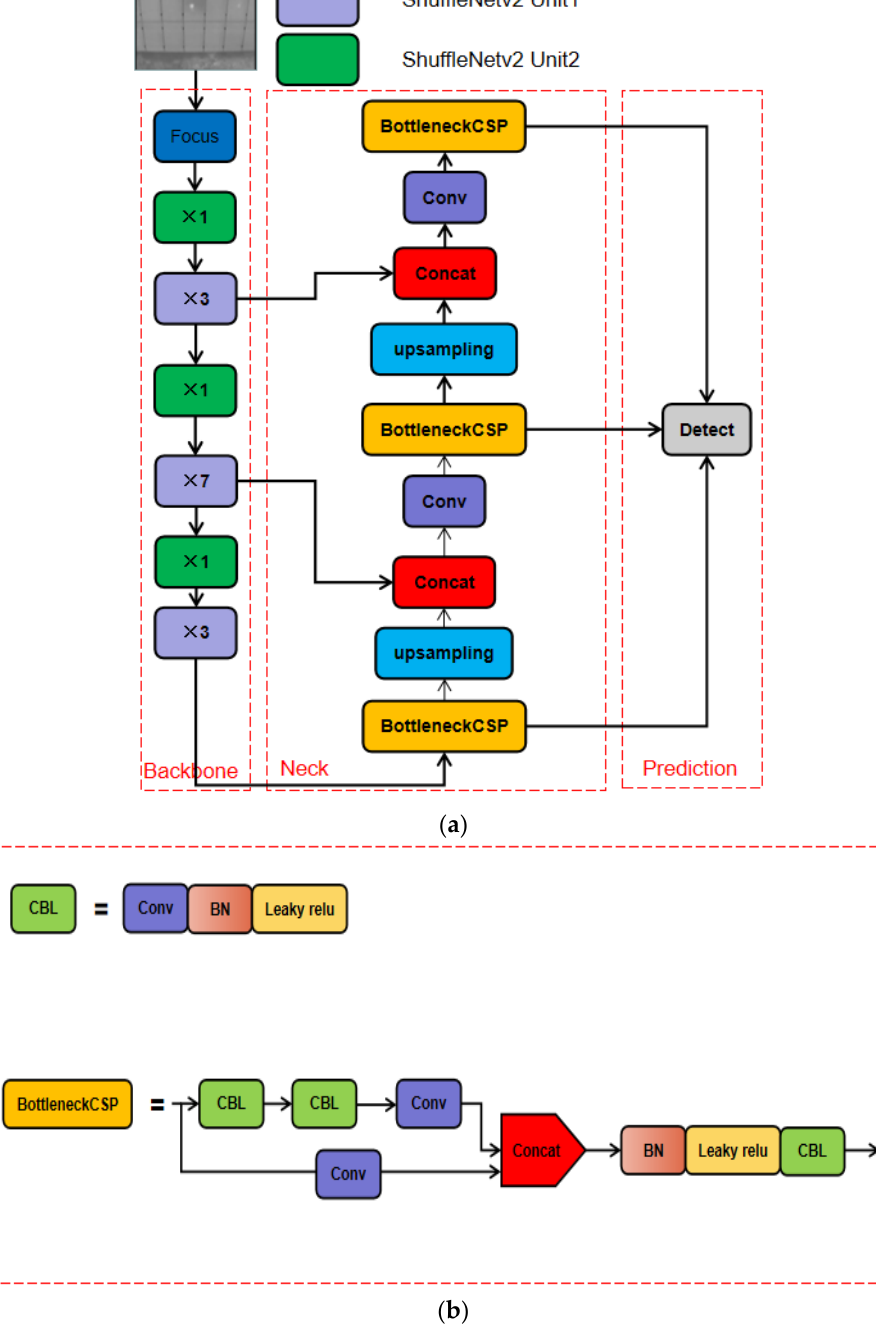
Figure 3. ( a ) Architecture of S-YOLOv5 network. ( b ) Architecture of BottleneckCSP. The backbone consists of Focus and the base unit of ShuffleNetv2 [33]. The number after × indicates the number of modules. Focus is located in the top layer of the backbone and can sample the images of the input neural network. Figure 4 shows the slicing process of Focus. The input image initially has only three channels, as shown in Figure 4a. Focus separates elements of each layer feature map to form four new feature maps. As a result,